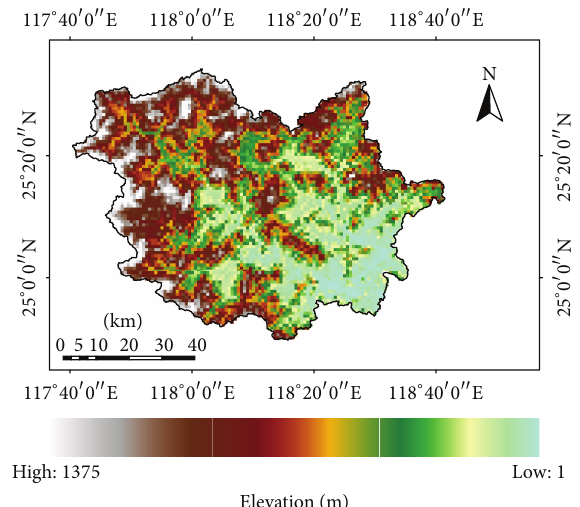
Figure 2: Topography of Jinjiang Basin.